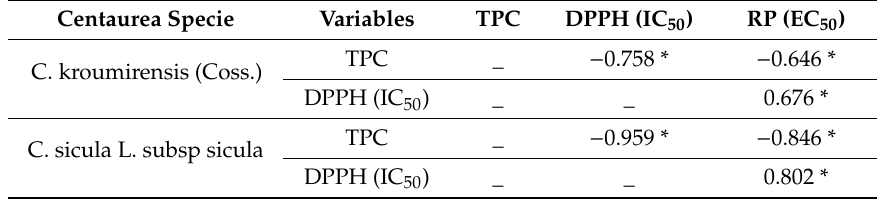
Table 2. Correlation (Pearson) and relationships between antioxidant capacity and (TPC) in Centaurea extracts. Values are with a significance ( p <